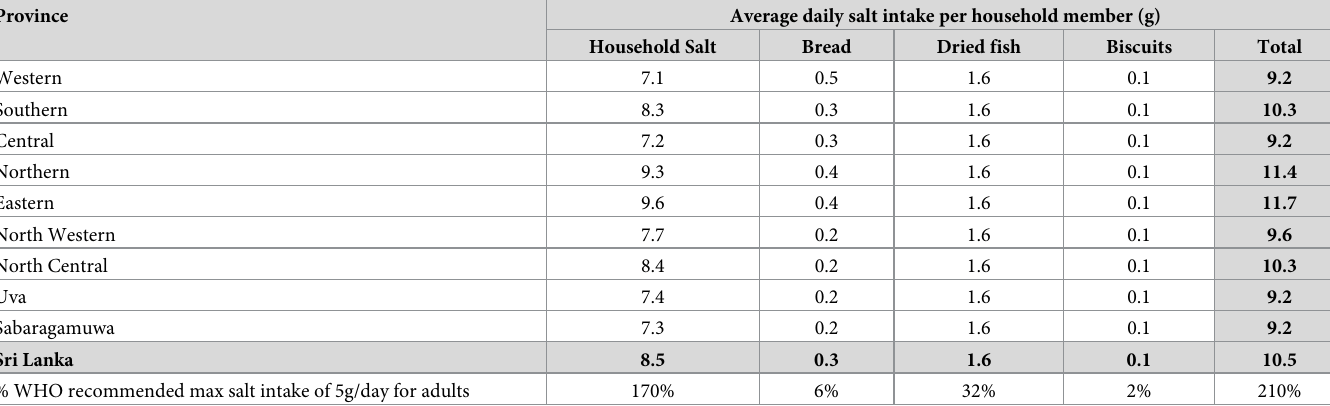
Table 2. Average daily salt intake per household member from household salt and selected commonly consumed IPF, nationally and by province. Province